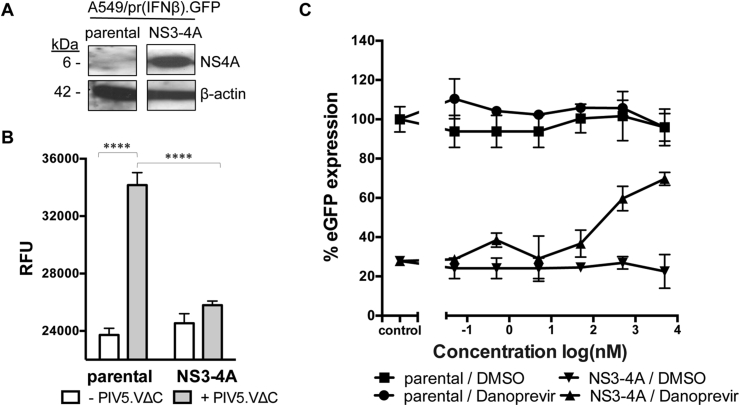
Restoration of eGFP expression in activated A549/pr(IFNβ).GFP-NS3-4A reporter cells by the HCV PI Danoprevir. (A) Detection of NS4A and β-actin in A549/pr(IFNβ).GFP or A549/pr(IFNβ).GFP-NS3-4A reporter cells. Cells were lysed and subjected to SDS-PAGE/Western blot, followed by detection with anti-V5 or anti-actin antibody and HRP-conjugated secondary antibody. Bands were visualized by chemiluminescence. (B) Effect of NS3-4A on eGFP reporter gene expression upon activation of the IFN induction pathway. A549/pr(IFNβ).GFP or A549/pr(IFNβ).GFP-NS3-4A reporter cells were infected with PIV5.VΔC to activate the IFN induction pathway. Sixteen hours post-infection eGFP expression was measured as raw fluorescent units (RFU). Statistical significance was assessed using a two-way ANOVA test: ****, p < 0.0001. Data shown represents mean values (n = 6 replicates; error bars = SD) and is representative of at least 3 independent experiments. (C) Effect of HCV PI Danoprevir on restoration of eGFP expression upon activation of the IFN induction pathway. A549/pr(IFNβ).GFP or A549/pr(IFNβ).GFP-NS3-4A reporter cells were treated with Danoprevir using a 6-point dose response curve (10-fold dilution series 0.05 nM-5 μM) or equivalent volume of DMSO (control). Two hours post-compound treatment cells were infected with PIV5VΔC. Sixteen hours post-infection eGFP expression was measured and % eGFP calculated relative to non-treated/PIV5.VΔC-infected A549/pr(IFN-β)GFP reporters cells, which represent 100%. Data shown represents mean values (n = 3 replicates; error bars = SD) and is representative of at least 3 independent experiments.